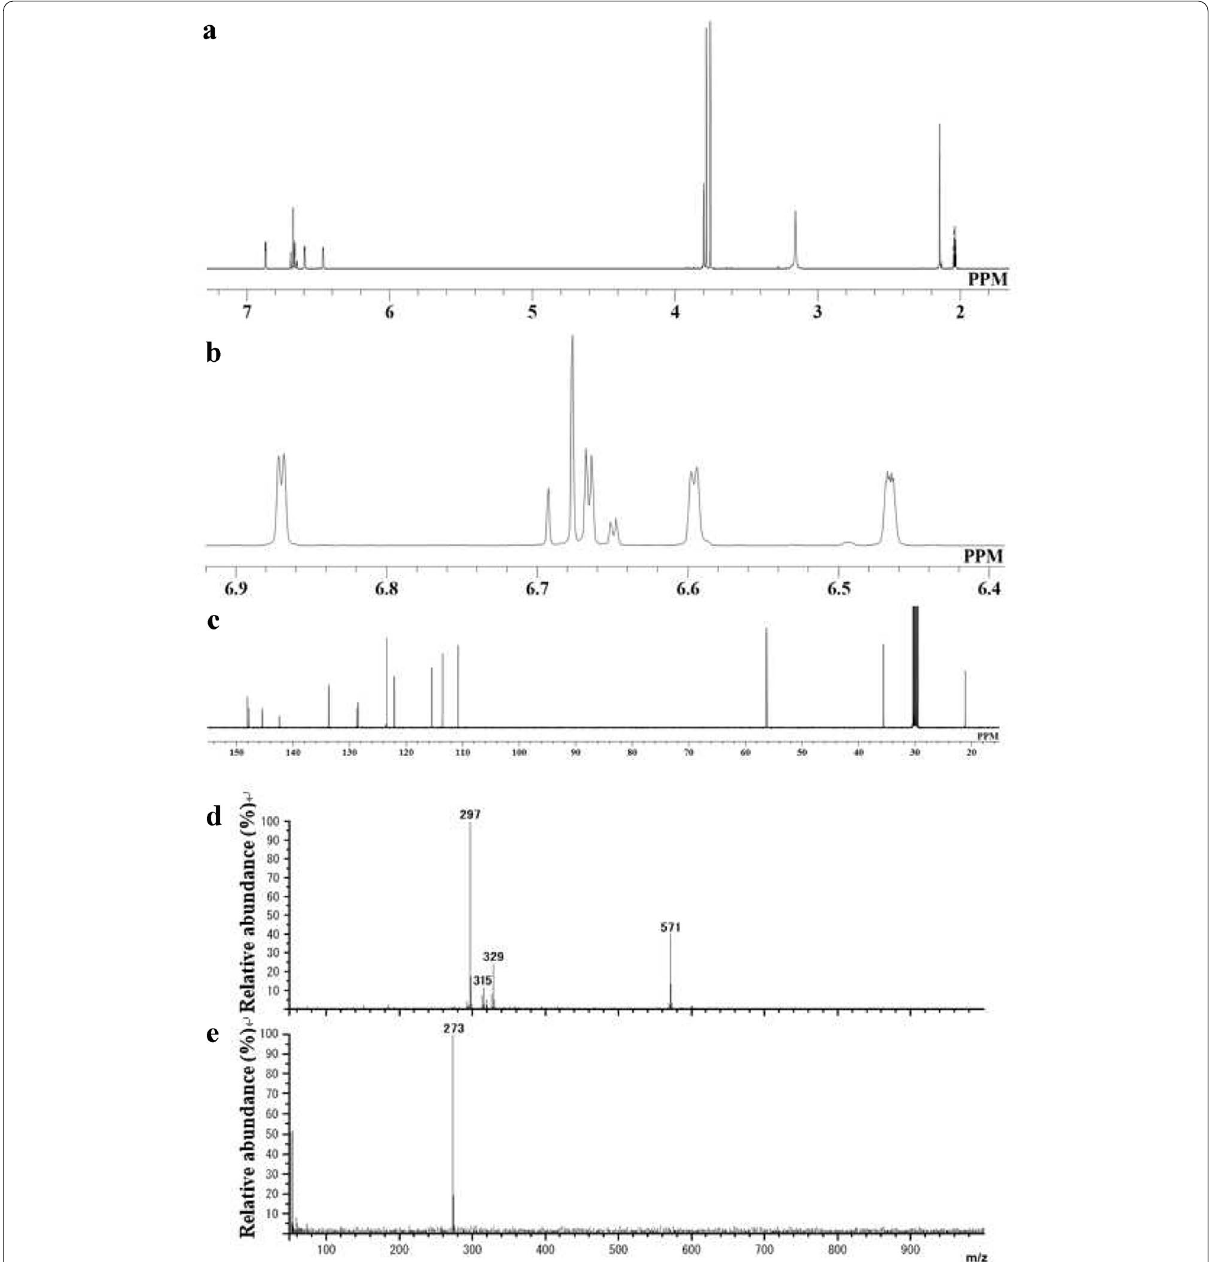
Fig. 4 Spectra of a 1 H-NMR, b low field region of 1 H-NMR, c 13 C-NMR, d positive mode of MS obtained by the ESI method, and e negative mode of MS obtained by the ESI